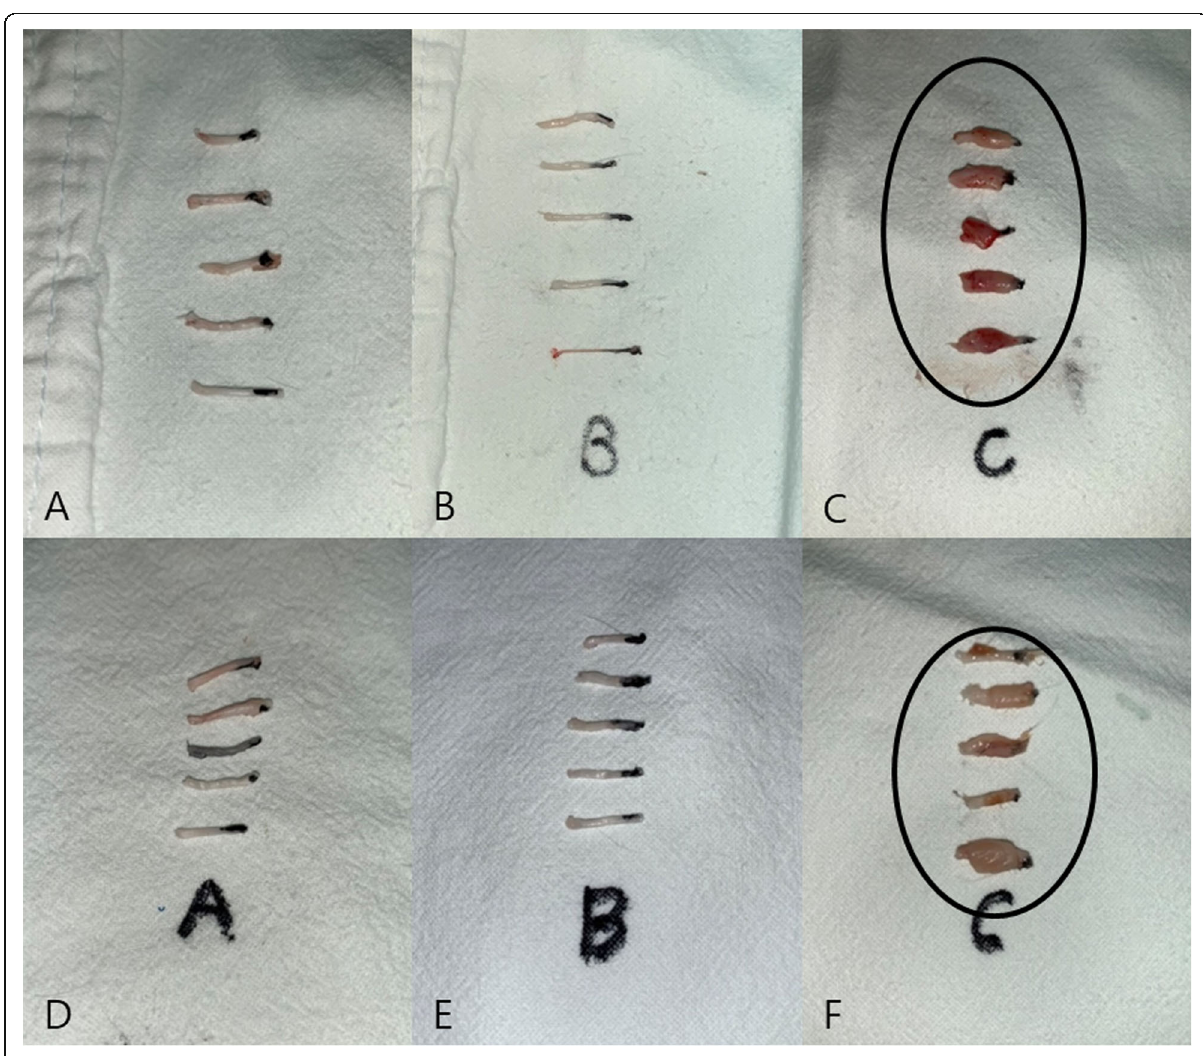
Fig. 6 Sciatic nerve segments. All tissues were harvested with a length of 10 mm, and the proximal area was marked with black ink. A Nerve segments of group A at 2 weeks. B Nerve segments of group A at 4 weeks. C Nerve segments of group B at 2 weeks. D Nerve segments of group B at 4 weeks. E Nerve segments of group C at 2 weeks. F Nerve segments of group C at 4 weeks. The collagen membrane is demonstrated to be maintained at both periods (circle) in panels C and